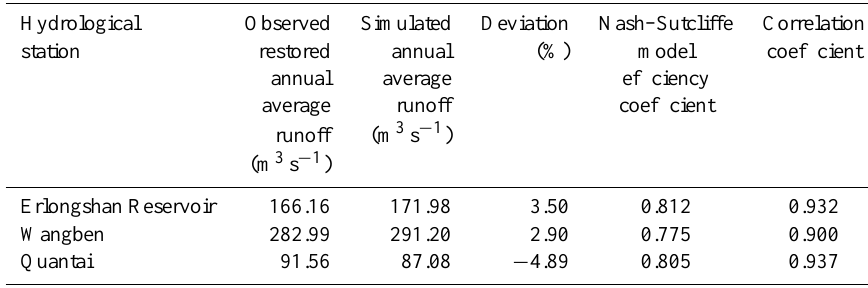
Table 3. Comparing the simulated and observed restored monthly runoff from 1960 to